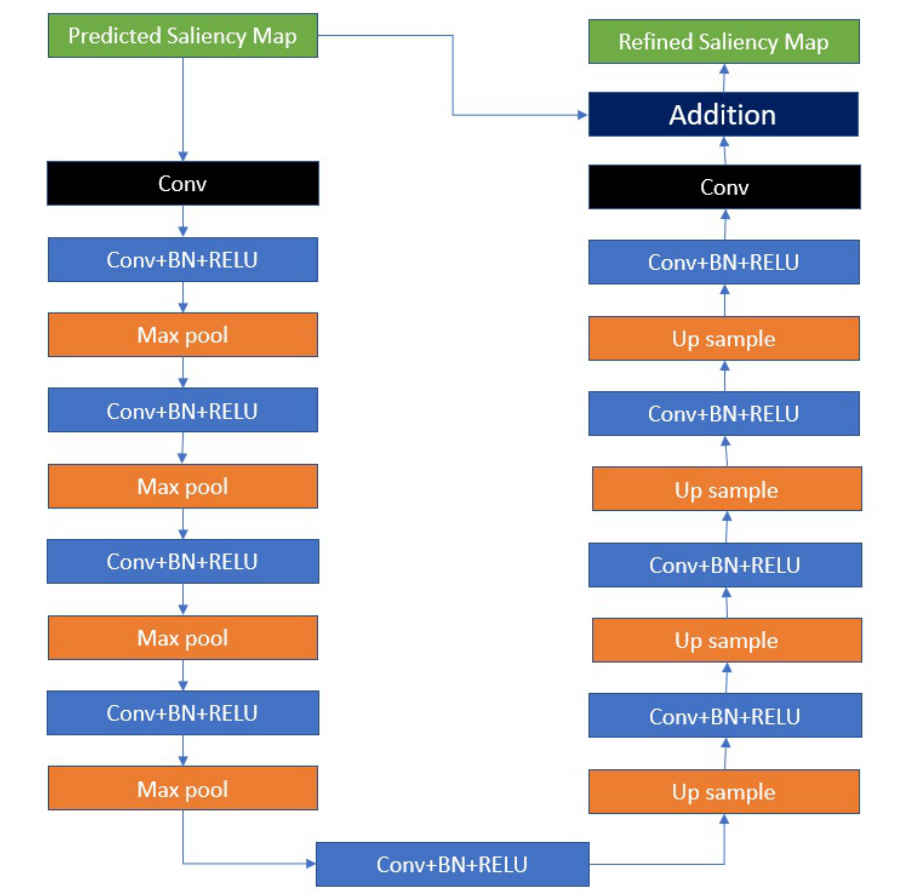
Figure 6. Encoder/decoder flow to extract refined saliency